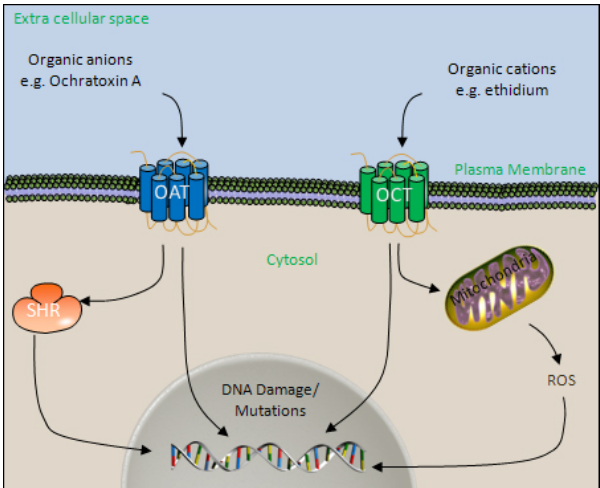
Figure 1. The initiation/promotion theory of cancer progression DNA damage resulting from multiple possible sources, including chemical exposure may result in the acquisition of pro-cancerous mutations (initiation). Upon detection, DNA repair mechanisms may amend the altered genome, or induce apoptosis. Failure to do so may result in the clonal expansion of the initiated cell (promotion and